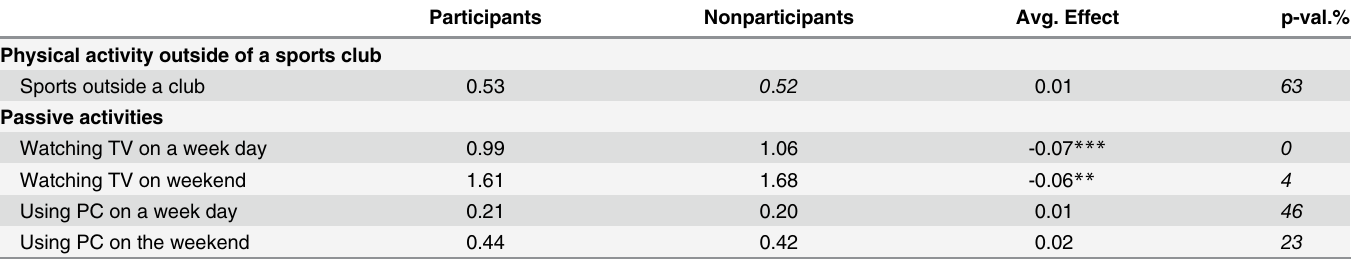
Table 9. Average effects on alternative activities (KiGGS). Note: P-values are computed by bootstrapping p-values of the t-statistic with 4999 replica- tions. Sports exercised outside a club is measured as a binary variable, where 1 indicates a child is doing at least once per week sports outside a club. All other activities are measured as hours per